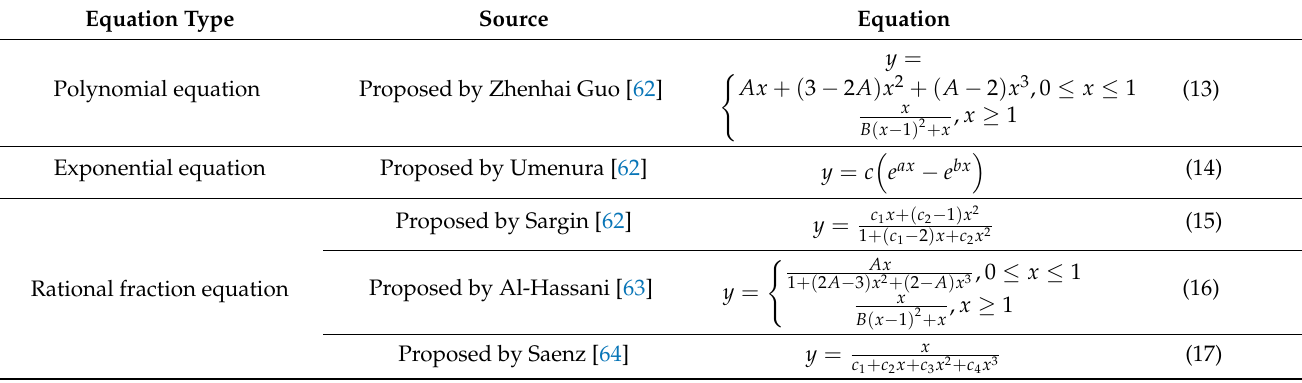
Table 12. Complete stress–strain curve equations for concrete under axial